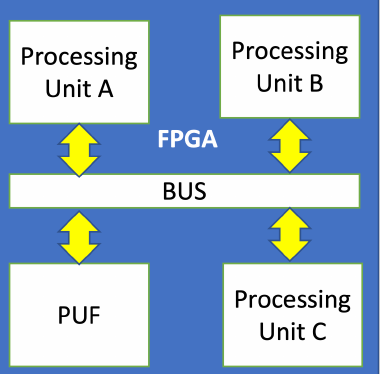
Figure 1. Modular architecture for FPGA-based IoT